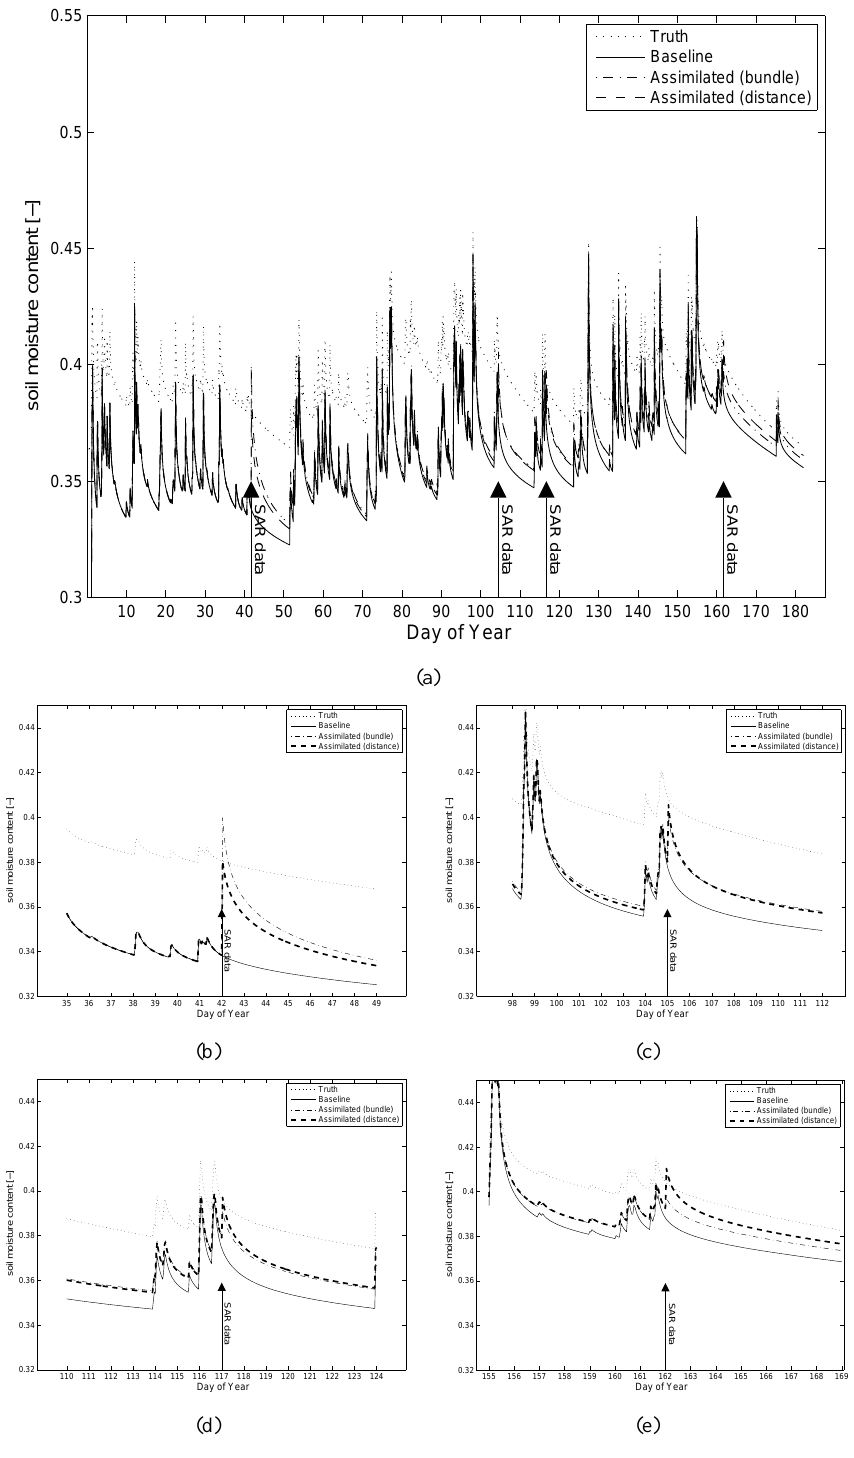
Fig. 9. Field averaged soil moisture content modelled in different model runs (truth, baseline run and assimilated run). Time steps at which SAR data is acquired are also indicated. (a) Overview of the entire time series, (b) detail of assimilation at DOY 42, (c) detail of assimilation at DOY 105, (d) detail of assimilation at DOY 117 and (e) detail of assimilation at DOY 162. The optimisation in the assimilated runs was performed w.r.t. the information present in the bundle (bundle ) or w.r.t. the Wasserstein distance between the empiricial and the central cumulative normal distribution in the bundle (distance).